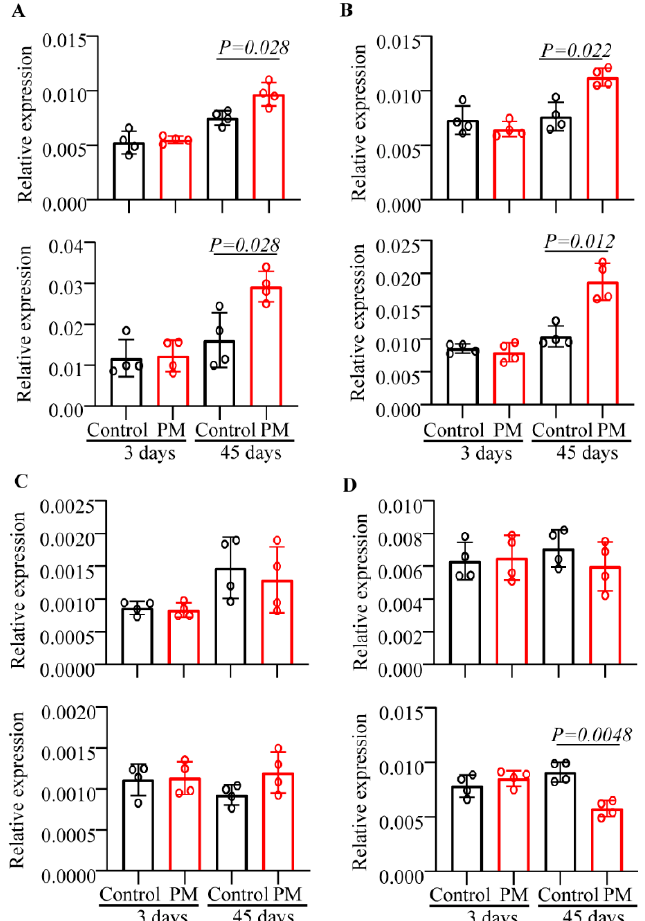
Figure 4. Prolonged treatment with PM causes immune activation in the gut mucosa. B6 mice were given PM by oral gavage for 3 or 45 consecutive days and euthanized after 24 h to harvest the intestine. cDNA preparations of the small intestine (SI; distal ileum; upper panels) and large intestine (LI; lower panels) were subjected to qPCR and the expression levels of cytokines and non-cytokine factors TNF α ( A ), IL10 ( B ), Raldh1A2 ( C ), and IL6 ( D ) were compared. Expression levels relative to β -actin expression were plotted. n = 4 mice / group and the assay was performed in triplicate for each sample. p -values by Mann–Whitney